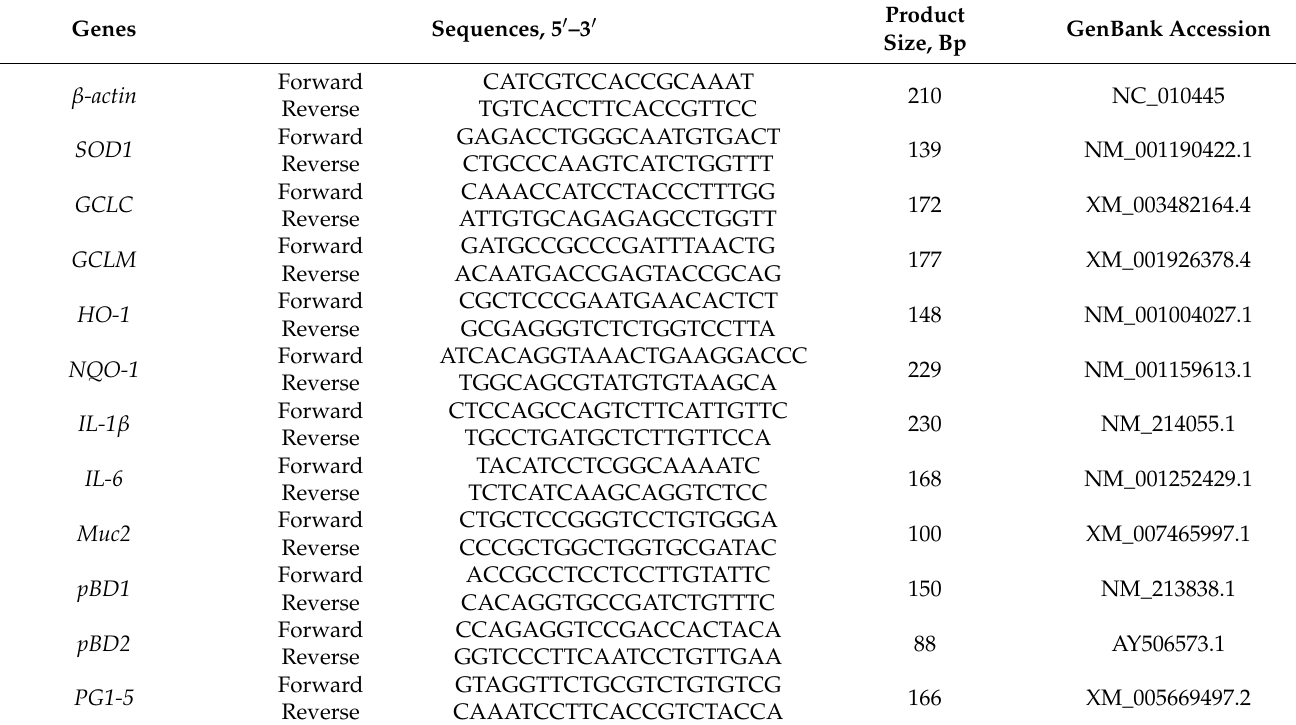
Table 3. Primer sequences used in this